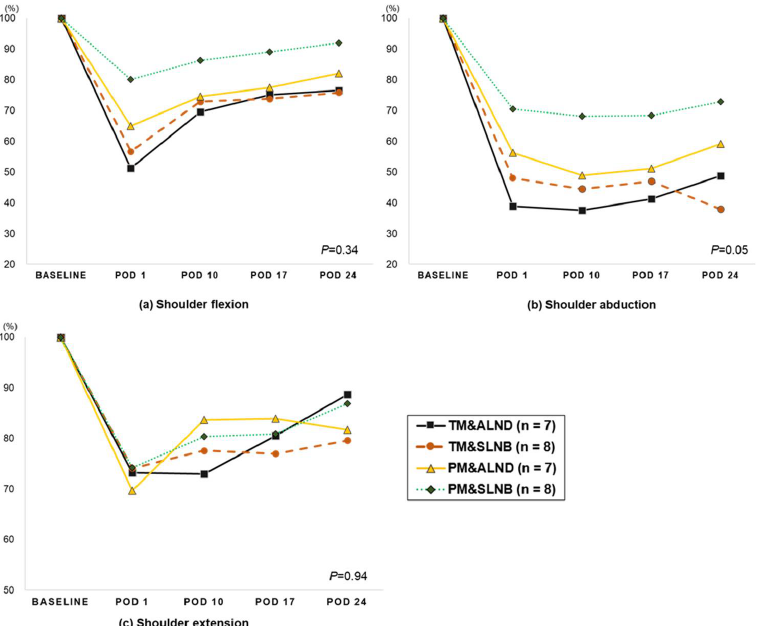
Figure 1. The changes in the shoulder range of motion after breast surgery according to the surgery type in the affected side (descriptive). P : the repeated measure of ANOVA analysis (group time interaction). Abbreviation: Total mastectomy with axillary lymph node dissection; TM&ALND, Total mastectomy with sentinel node biopsy; TM&SLNB,